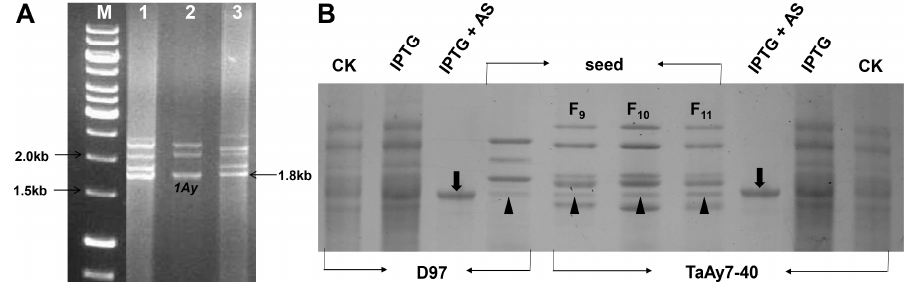
Figure 3. Complete open reading frame (ORF) of HMW-GS amplified by PCR ( A ) and heterologous expression of the 1Ay gene ( B ). ( A ) PCR amplification of HMW-GS ORFs. Lanes 1, 2, and 3: CN16, D97, and TaAy7-40, respectively. M: DNA marker; the arrowhead indicates the 1Ay fragment. ( B ) Heterologous expression of the 1Ay gene of D97 and TaAy7-40 in Escherichia coli BL21 (DE3). IPTG, the protein from E. coli cultured with isopropyl β - Δ -thiogalactopyranoside (IPTG) using the general extraction method. IPTG+AS, the IPTG induced 1Ay protein extracted using acetone sedimentation (AS). CK indicates the protein from E. coli cultured without IPTG using the general traction method. Arrowheads point to the expressed 1Ay subunit protein from E. coli culture; triangles point to the 1Ay protein extracted from endosperms of D97 and TaAy7-40 (F 9 to F 11